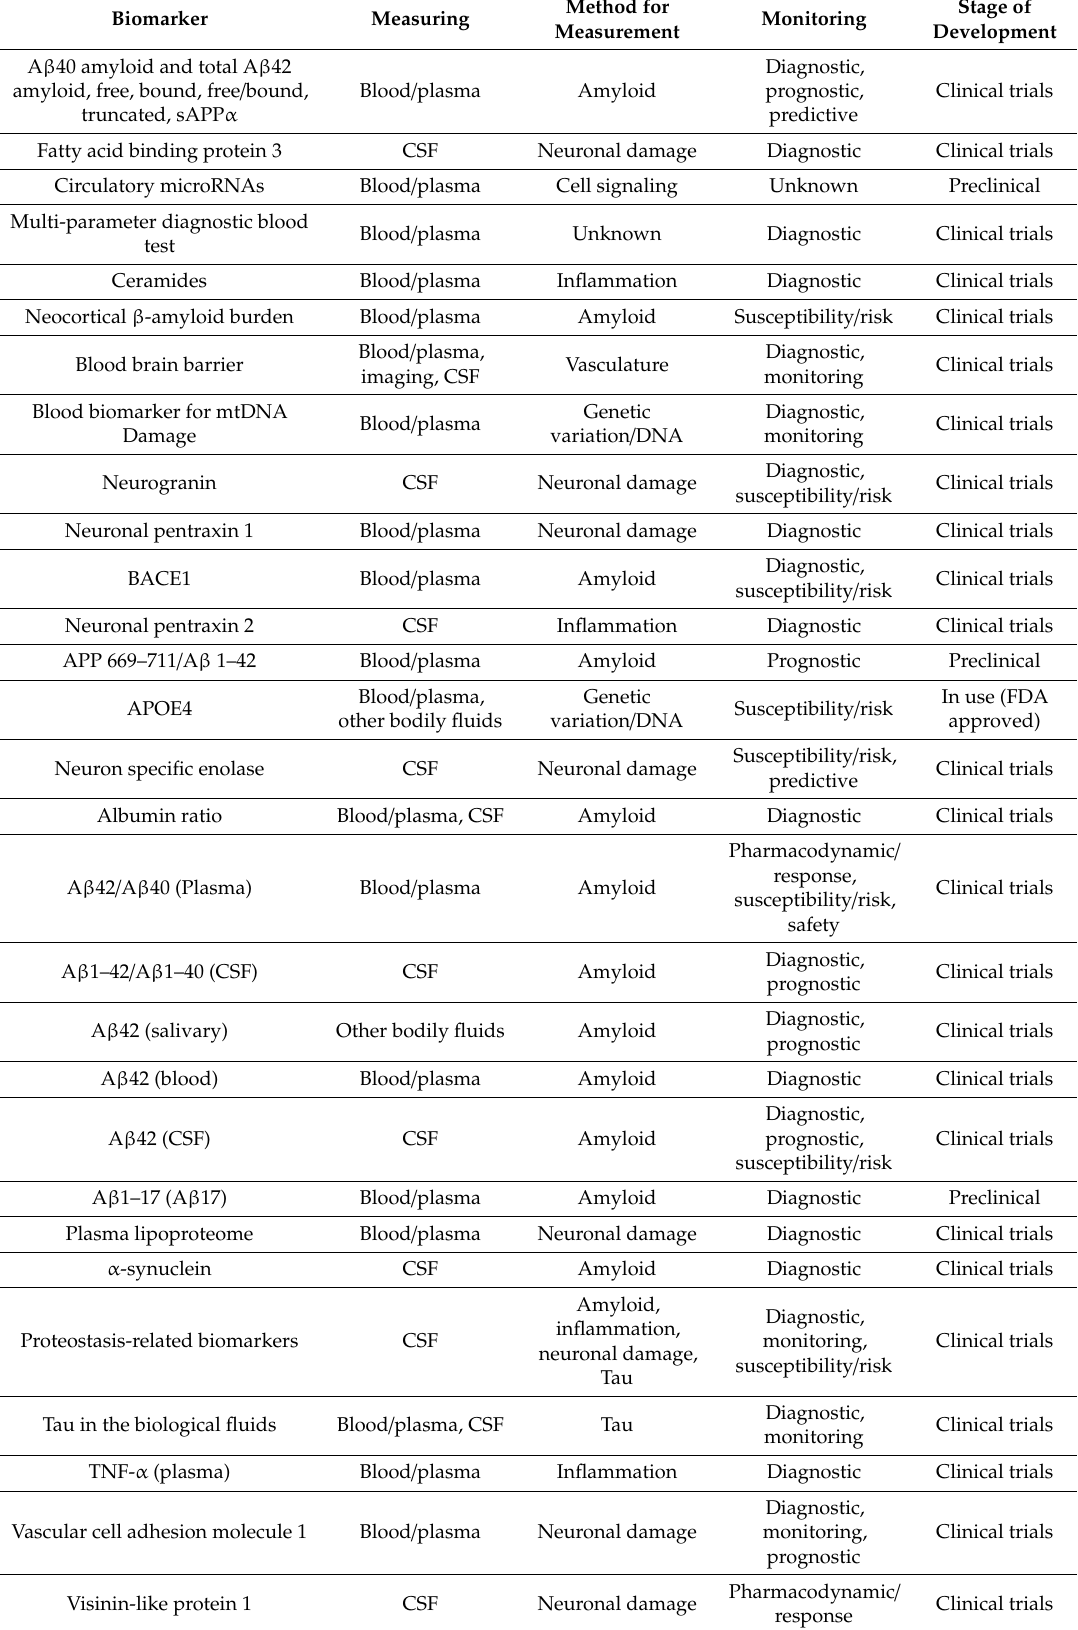
Table 2. Summary of the current development of body-fluid biomarkers for Alzheimer’s